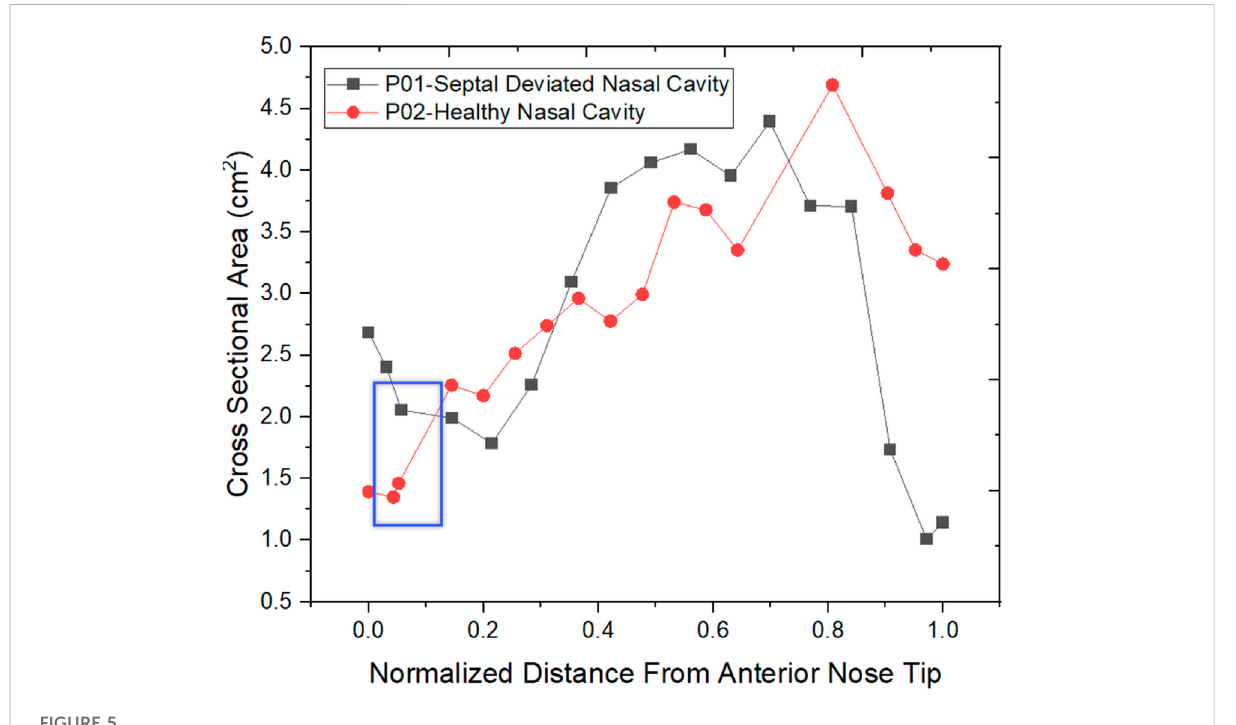
FIGURE 5 Cross-Sectional area